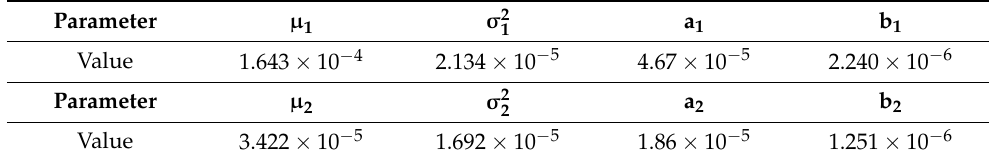
Table 3. Estimation results of parameters in this paper.